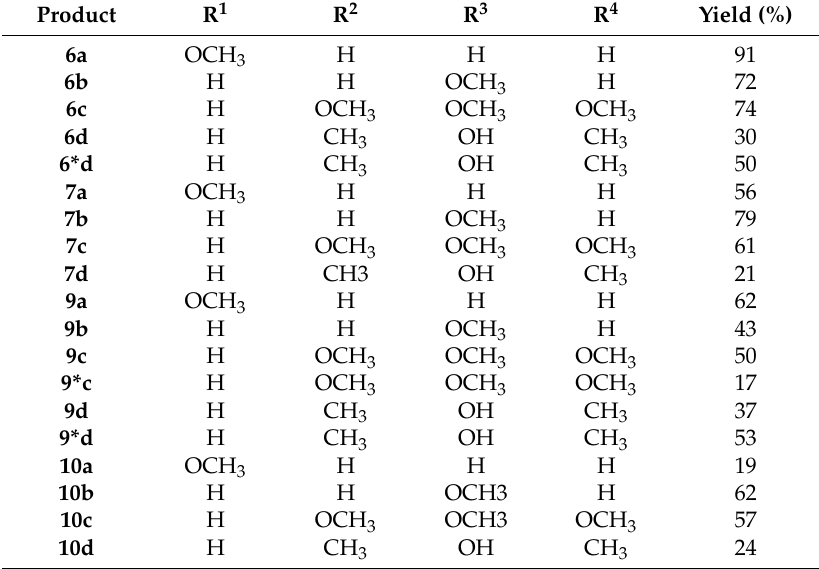
Table 2. Designation and isolated yields of cinchona-chalcone hybrids types 6 , 7 , 9 and 10 with